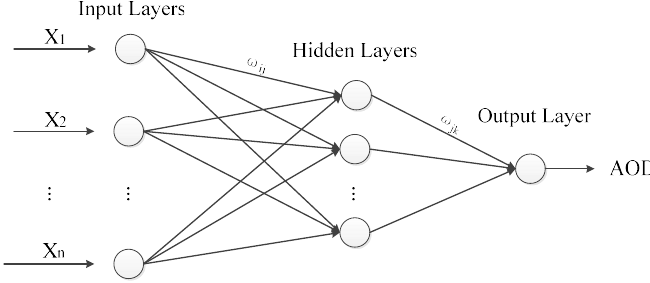
Figure 4. The basic schematic architecture of the BP neural network used in this study.